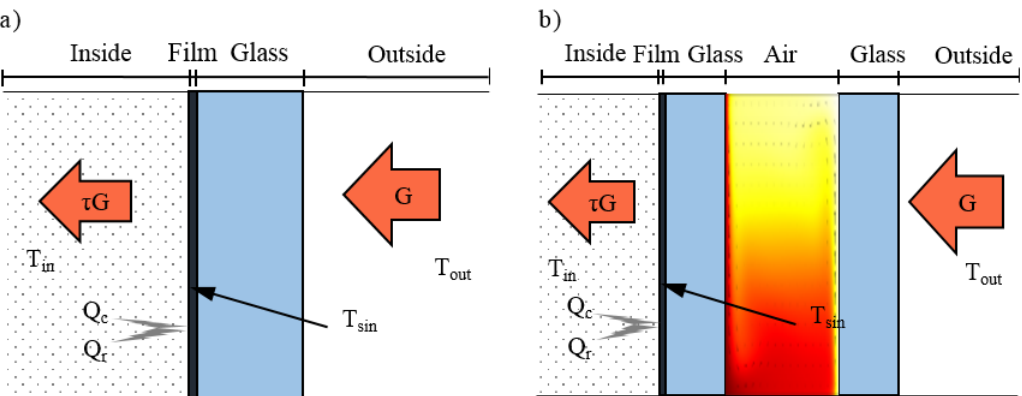
Figure 2. Heat transfer process of SSAF coated glazing systems: ( a ) SG+F [21]; ( b ) DG+F (T sin : the inner surface temperature).